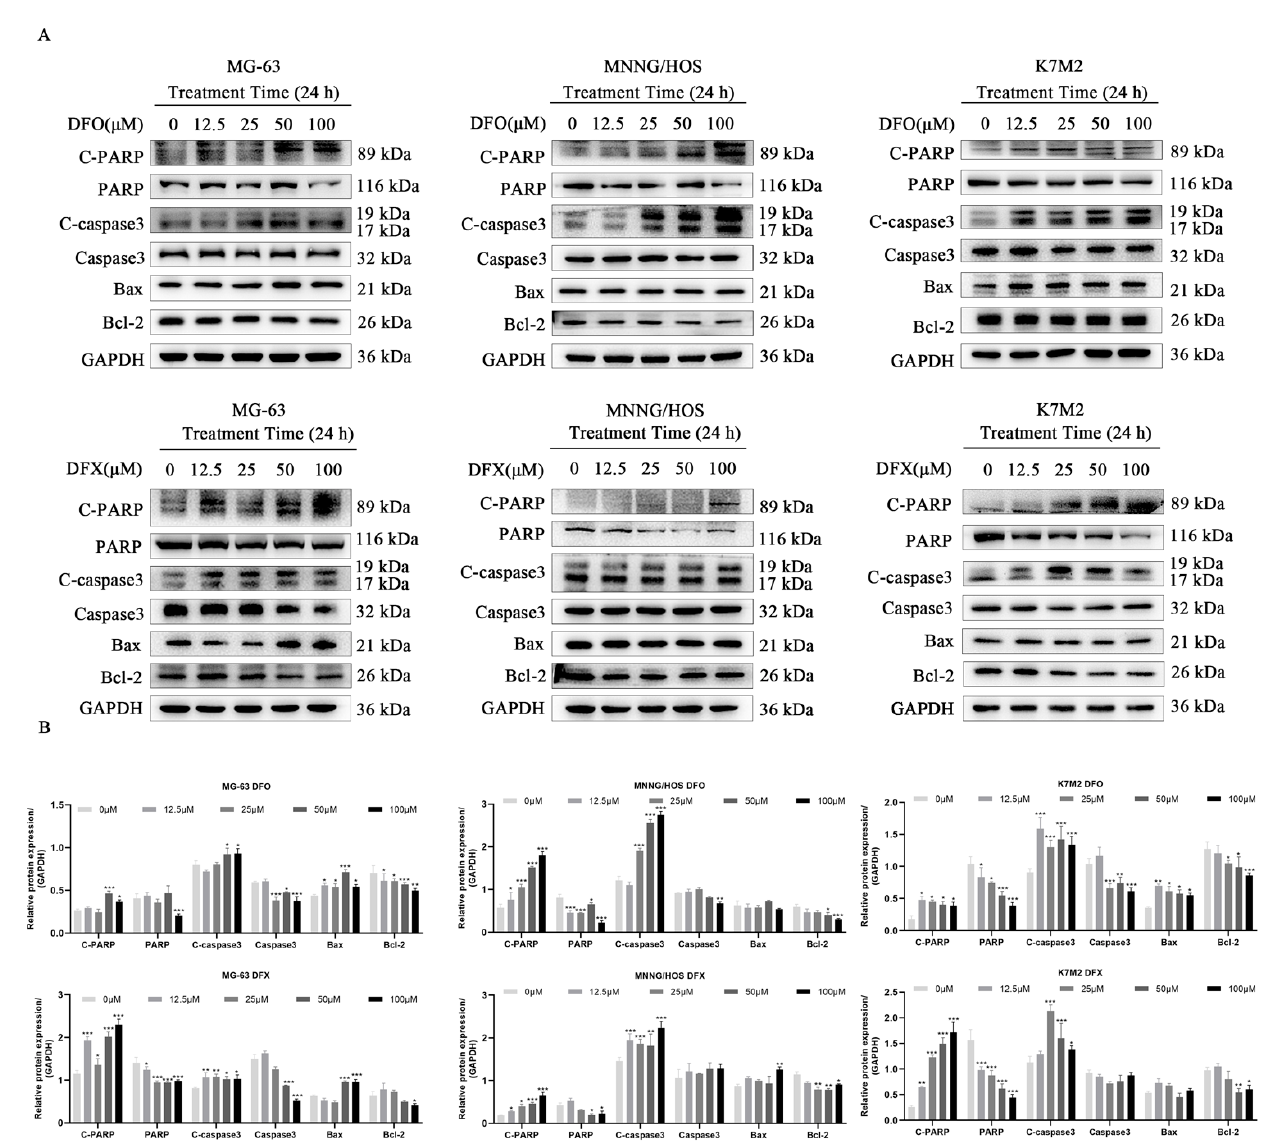
Figure 5. Iron chelators induced apoptosis in osteosarcoma cells. ( A ) Protein expression levels of Caspase-3, C-caspase-3, Bcl2, Bax, and C-PARP in MG-63, MNNG/HOS and K7M2 cells treated with the indicated concentrations of DFO and DFX for 24 h. ( B ) Quantitative analysis of C-PARP, PARP, C-caspase-3, caspase-3, Bax and Bcl2 in MG-63, MNNG/HOS and K7M2 cells treated with the indicated concentrations of DFO and DFX for 24 h (n = 3). * p < 0.05, ** p < 0.01 and *** p < 0.001 versus control group.